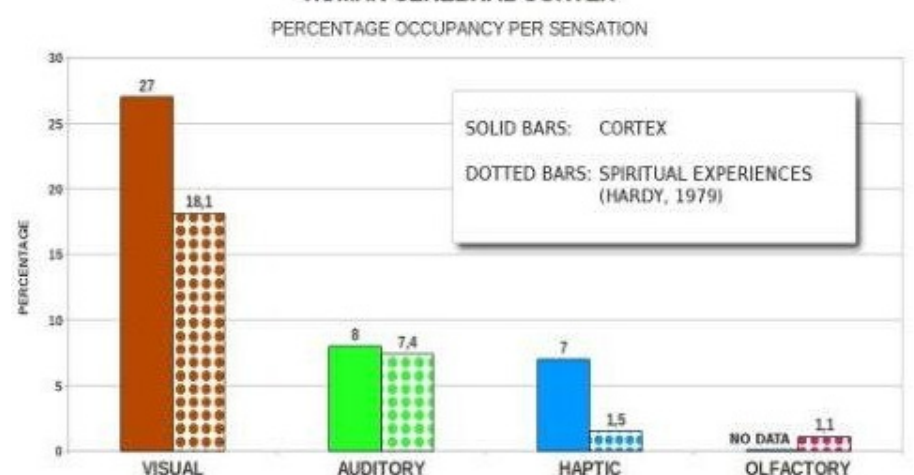
Figure 3. Recent computer ‐ aided studies of the human cerebral cortex have provided calculations of percentage occupancy for all the major sensory areas [77]. Below, against those percentage occupancies, are plotted the frequency of religious encounters classified by Hardy [76] as visual, auditory, tactile etc. There is a very close relationship between the two sets of data, firmly indicating that the contours of religious experiences (whether visual, auditory, etc. ) closely follow the contours of the brain’s involvement in these sensory attributes. Had these experiences originated from “outside” sources, one might have expected a different pattern or even one which did not, in the least, follow their cortical representations. Many of the subjects recorded by Hardy underwent features of ND/OBE. (Note that these data do not include other relevant functional areas of cortex which cannot be quantitated as easily as the major sensory areas).